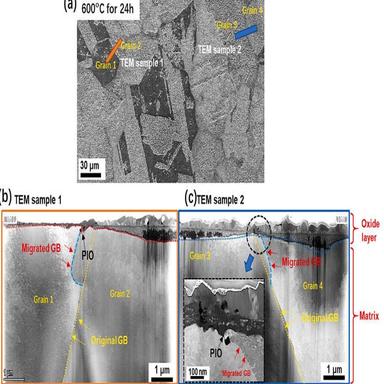
(a) SEM image showing the positions of the two TEM foils after exposure in SCW at 600 ◦C for 24 h, (b) TEM HAADF image of the TEM sample 1, (c) TEM HAADF image of the TEM sample 2.